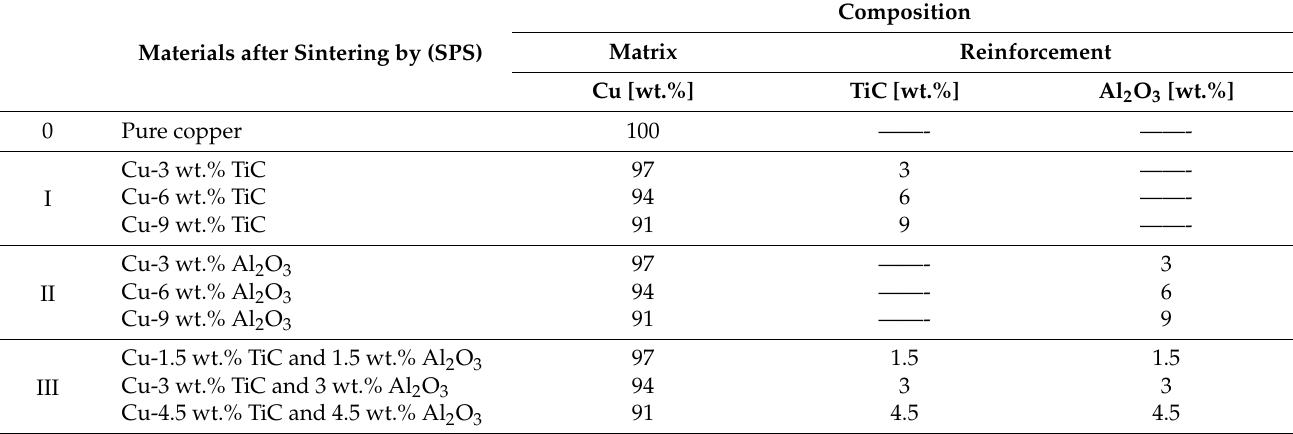
Composition Matrix